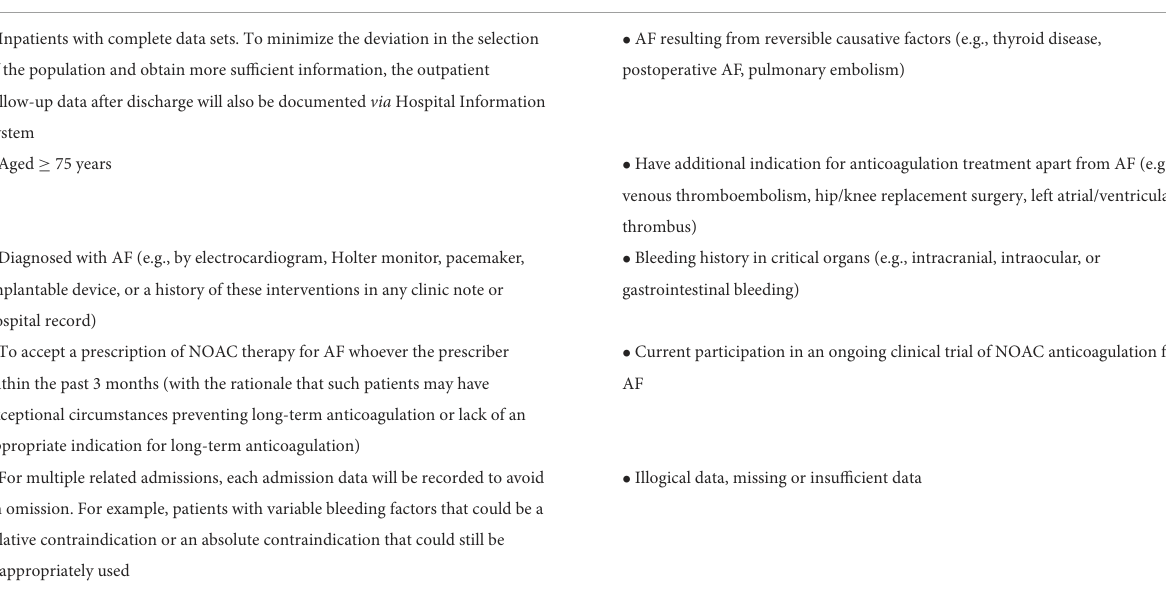
TABLE 1 Inclusion and exclusion